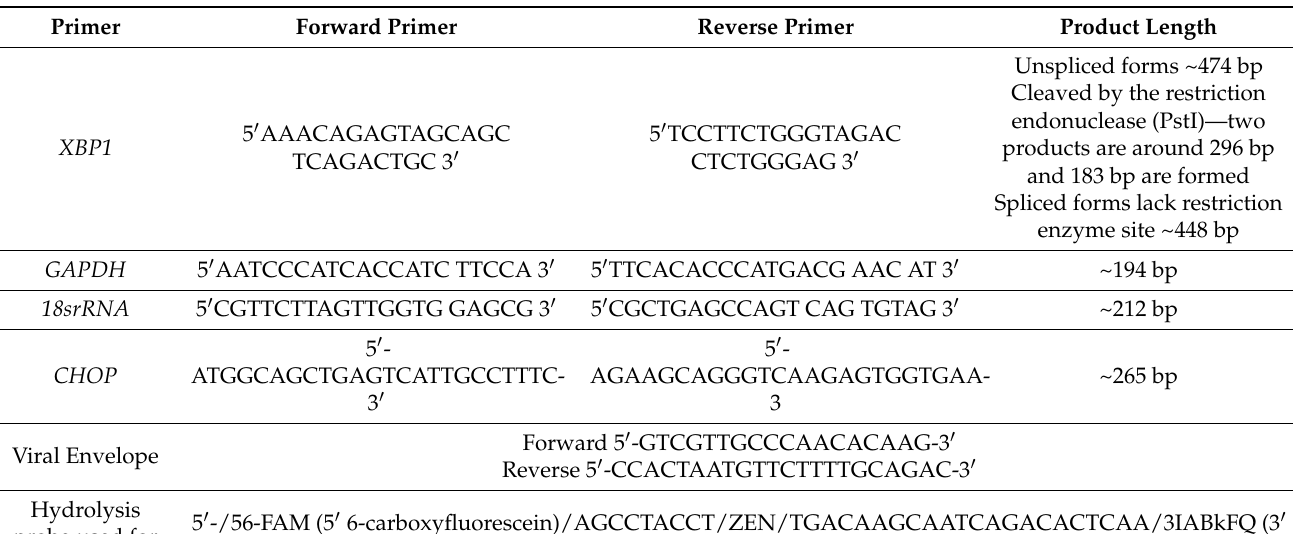
Table 1. List of primers